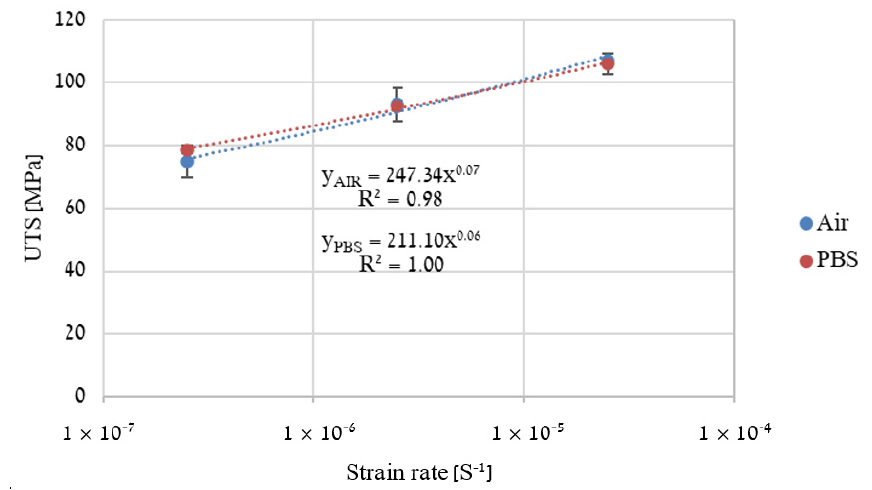
Figure 5. UTS vs. strain rate of Zn-2%Fe-0.6%Ca alloy in air and PBS Figure 5. UTS Vs. strain rate of Zn-2%Fe-0.6%Ca alloy in air and PBS solution.